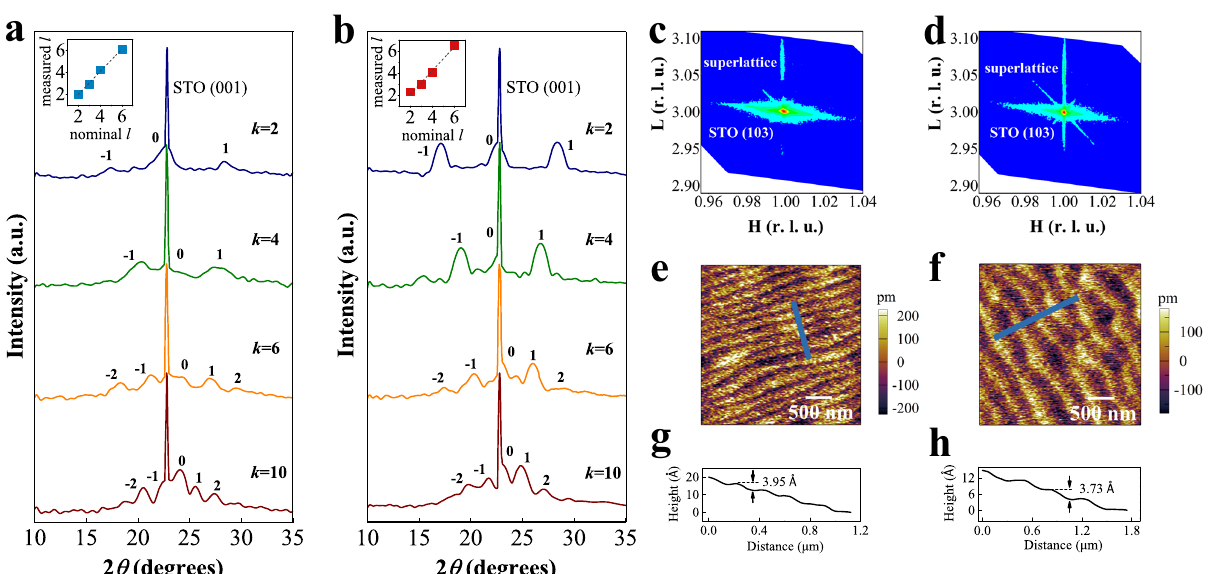
Fig. 1 Structural characterizations. X-ray diffraction patterns of a [(SrIrO 3 ) 2 /(NdNiO 3 ) k ] l and b [(SrIrO 3 ) 2 /(LaNiO 3 ) k ] l superlattices ( k = 2, 4, 6, 10) deposited on (001) SrTiO 3 (STO) substrates. The numbers above the patterns indicate the i th satellite peaks. The insets in a and b show the measured numbers of period plotted as functions of the nominal ones. Reciprocal space mappings of c [(SrIrO 3 ) 2 /(NdNiO 3 ) 10 ] 2 and d [(SrIrO 3 ) 2 /(LaNiO 3 ) 10 ] 2 superlattices around the STO (103) re fl ection. The atomic force microscope images of the e [(SrIrO 3 ) 2 /(NdNiO 3 ) 2 ] 6 and f [(SrIrO 3 ) 2 /(LaNiO 3 ) 2 ] 6 sample surface, respectively. g , h The corresponding height pro fi les along the blue lines on the atomic force microscope images of e and f , where the step height is obtained as 3.95 and 3.73 Å, respectively.